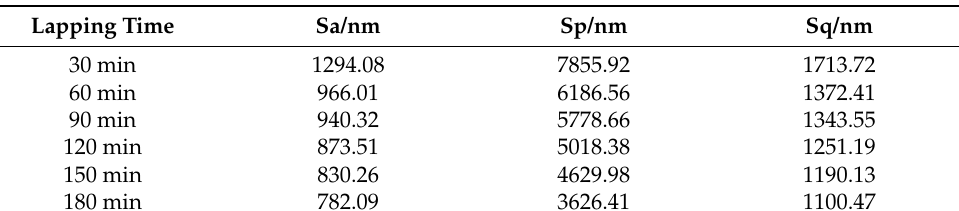
Table 4. Surface roughness and three-dimensional surface parameters of the FAP in each processing stage.